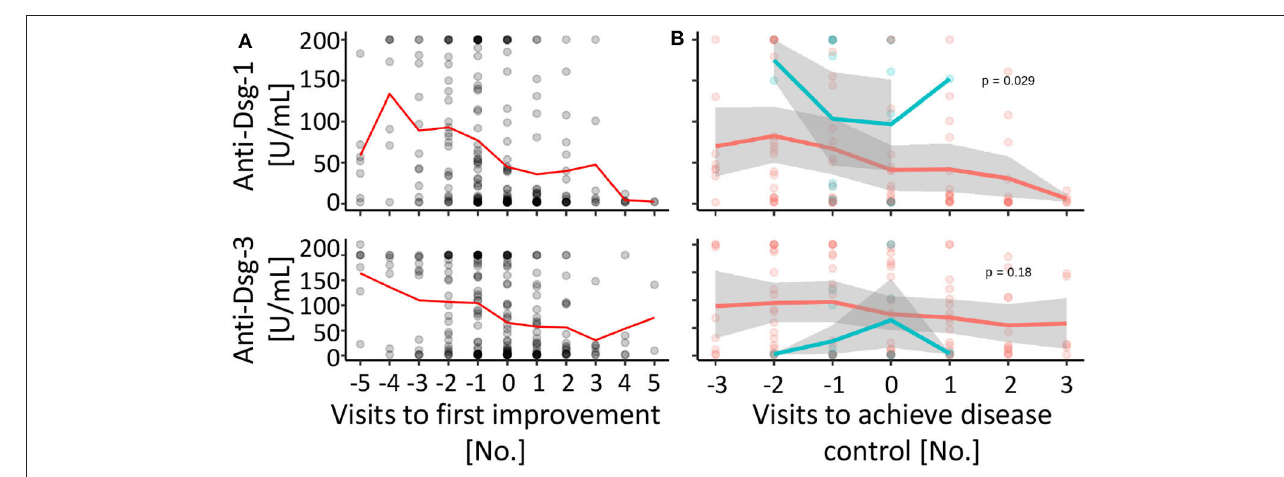
FIGURE 3 | Anti-desmoglein serum antibodies decline over time, but are not associated with therapy changes. (A) The individual anti-desmoglein-1 and − 3 serum concentrations (gray circles, overlapping values with a darker color intensity) and mean values (red line) were displayed for the respective visit [0 = first visit with clinical improvement, numbers of the visits before (negative) and after (positive) improvement]. (B) The autoantibody concentrations compared between subgroups with more ( > 4, red) or less ( ≤ 4, blue) than average therapy changes shown as individual values (circles) and mean (line) over time to achieve disease control (visit 0 = first visit with a severity score of 1 or 0). Gray area: 95% confidence interval. P -values calculated by repeated